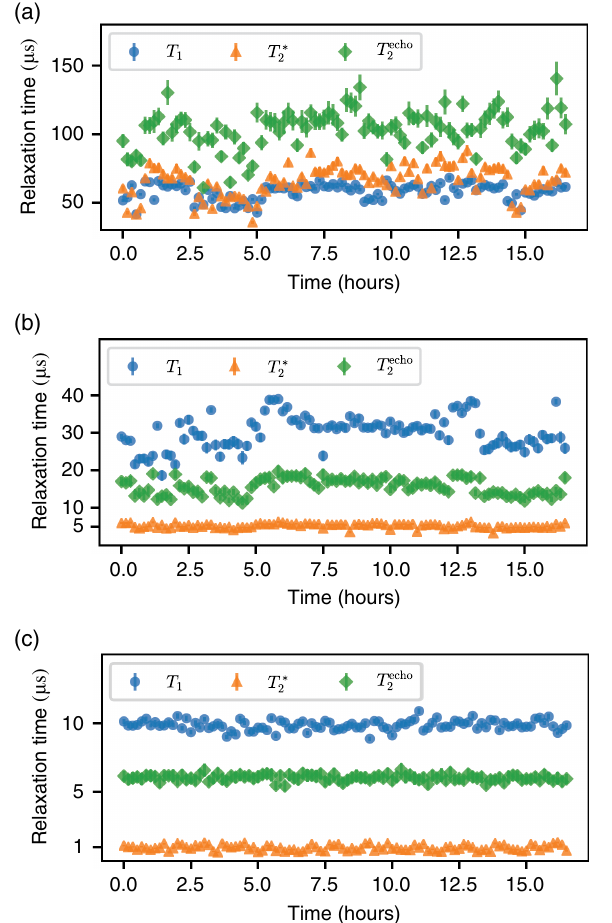
FIG. 8. Coherence times of QB1 (a), QB2 (b), and CPLR as a function of time.